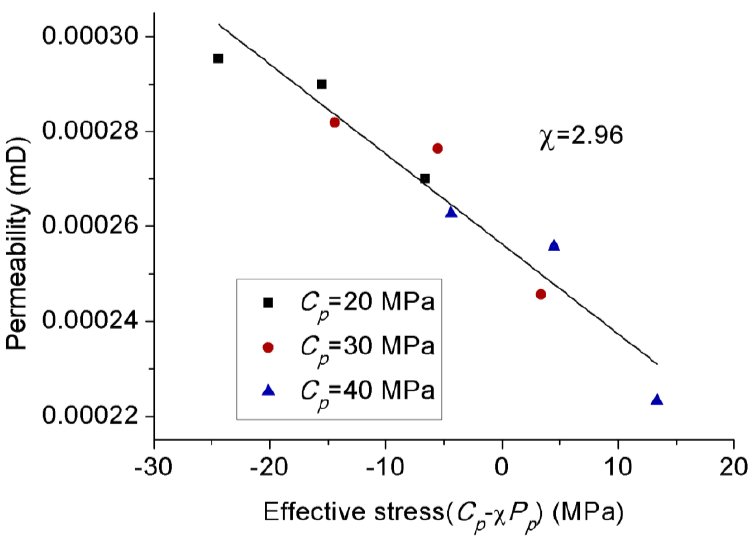
Figure 25. Permeability versus modified effective stress for liquid CO 2 state under transient